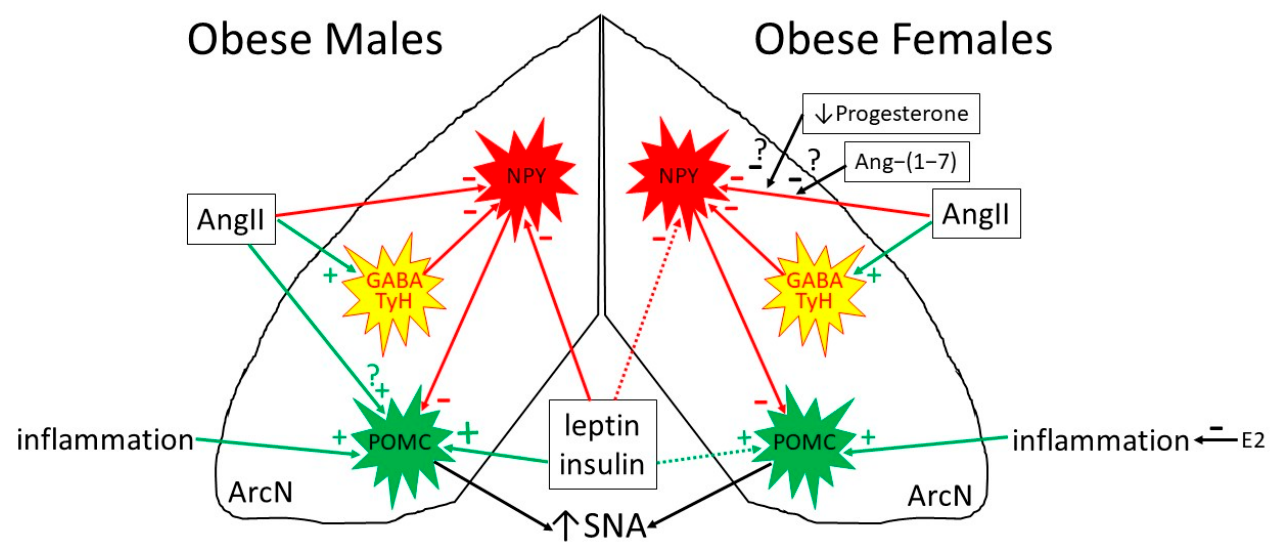
Figure 2. Hypothesized mechanisms underlying sex differences in the actions of elevated leptin and insulin levels to increase SNA during obesity. NPY: Neuropeptide Y; POMC: Pro-opiomelanocortin; ArcN: Arcuate nucleus; AngII: Angiotensin II; Ang-(1–7): Angiotensin 1–7; TyH: Tyrosine hydroxylase (marker of dopaminergic neurons); GABA: Gamma-aminobutyric acid; E2: Estrogen; SNA: Sympathetic nerve activity. Green arrows: stimulatory; red arrows: inhibitory. Dotted arrows indicate that NPY and POMC presympathetic neurons are resistant to the actions of leptin or insulin in obese females, whereas these actions are enhanced in obese males. See text and legend to Table 2 for details. Adapted in part from [24].